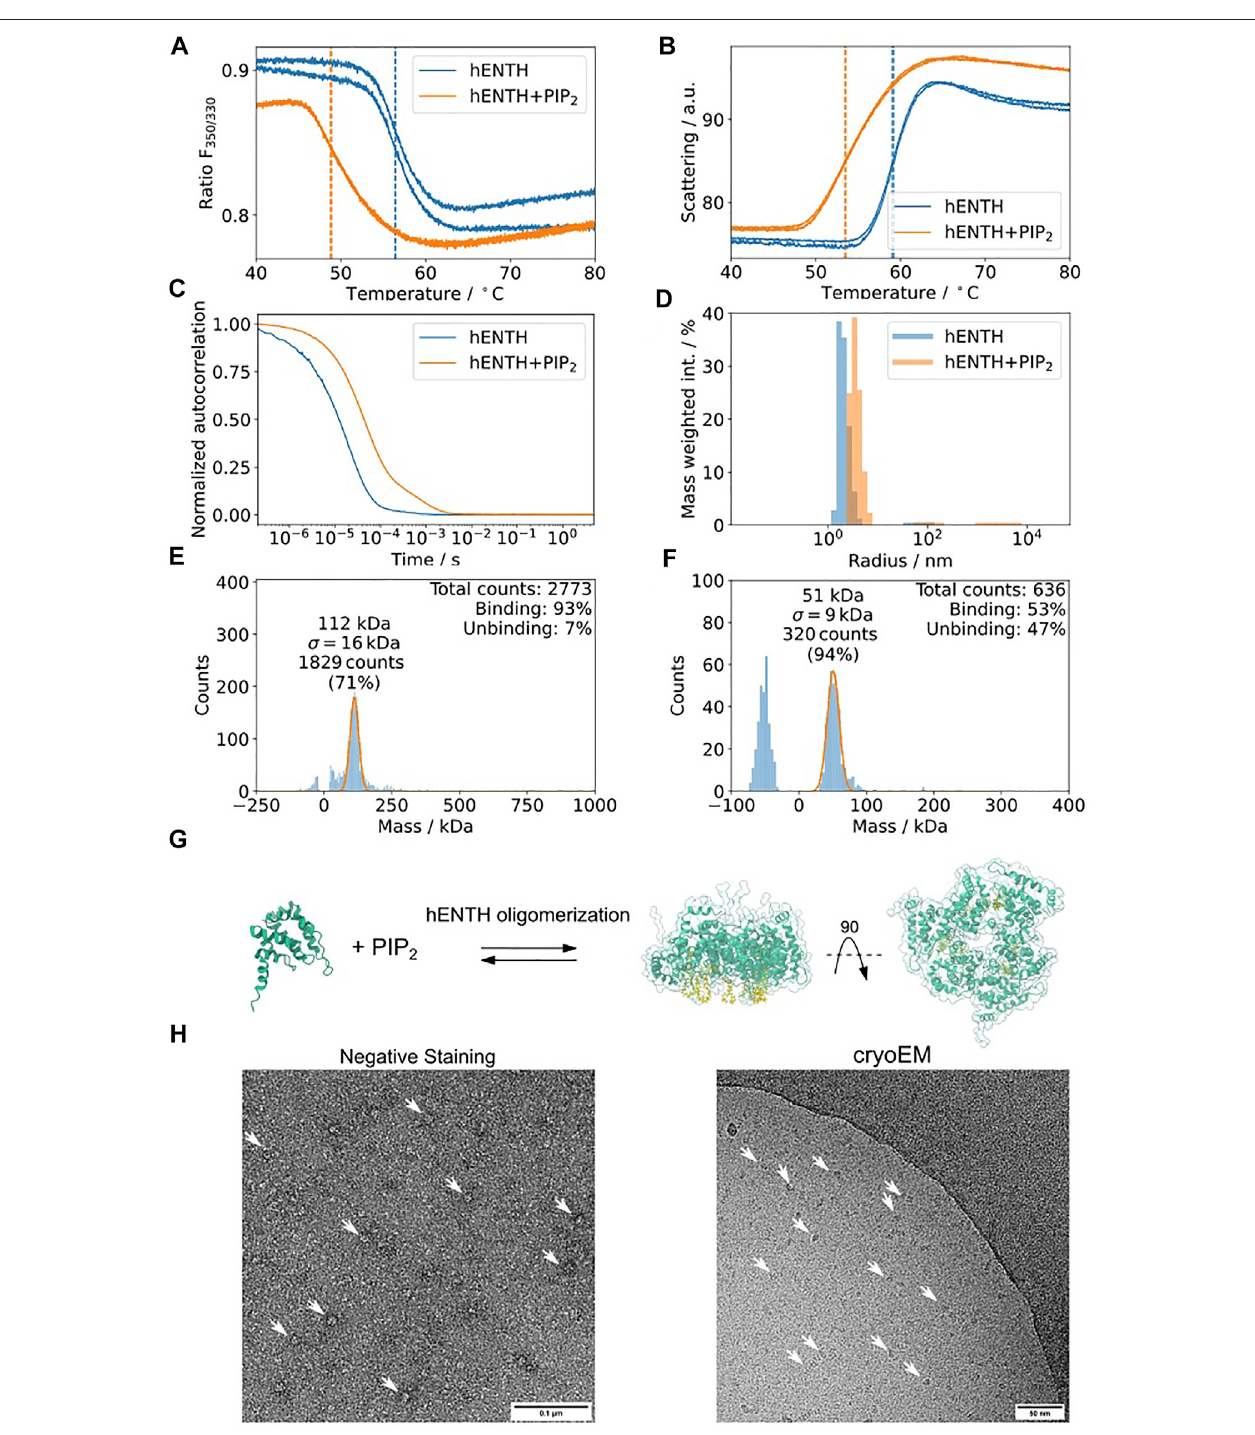
FIGURE 8 | hENTH forms complexes in micellar concentrations of PI(4,5)P 2 . (A) nDSF transitions for hENTH at 30 µM in the absence and presence of 200 µM PI(4,5)P 2 .TheshiftinthesamplewithPI(4,5)P 2 indicatesthattheoligomerunfoldsbeforethemonomers. (B) ScatteringcurvesofhENTHintheabsenceandpresenceof 200 µM PI(4,5)P 2 . The hENTH aggregates at lower temperature in the presence of PI(4,5)P 2 . (C) DLS auto-correlation curves of hENTH at 30 µM in the absence and presenceof200 µMPI(4,5)P 2 .TheshiftintheautocorrelationcurveindicatesthatthehENTHdomainoligomerizesinthepresenceofPI(4,5)P 2 . (D) Histogramofthe masses present on the DLS samples in the absence and presence of PI(4,5)P 2 . hENTH shifts towards higher masses in the presence of PI(4,5)P 2 , consistent with oligomer formation. (E) hENTH at 100 nM (monomer MW = 18.5 kDa) shows a peak at 108 kDa, corresponding to a hexamer of hENTH in the presence of 200 µM PI(4,5)P 2 at112 kDa. (F) Control:massphotometryhistogramofbufferwith200 µMPI(4,5)P 2 .Apeakatca.51 kDacorrespondstoPI(4,5)P 2 micelles. (G) Schematicof the hENTH domain (green) (PDB ID: 5ONF) and the oligomer model with PI(4,5)P 2 molecules (yellow) from Garcia-Alai et al., 2018. (H) Representative negative staining and cryo-electron micrograph of hENTH + PI(4,5)P 2 where hENTH hexamers can be observed. Particles of interest are indicated with white arrows.